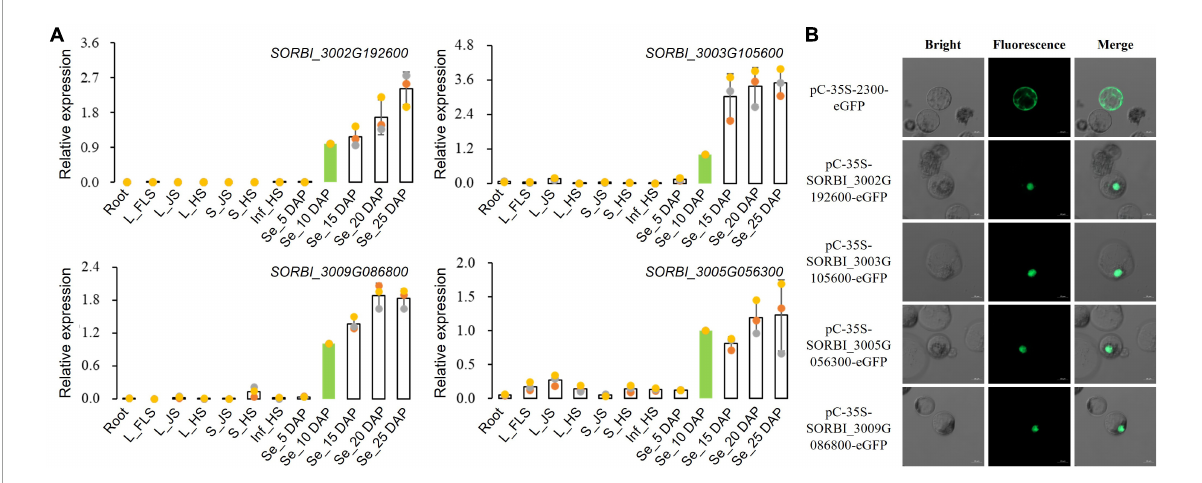
FIGURE5 Expression analysis and sub-cellular localization of NAC TFs. (A) qRT-PCR assays of four NAC-type TFs among different tissues. (B) Sub-cellular localization of four selected NAC-type TFs in the protoplasts of maize leaves.